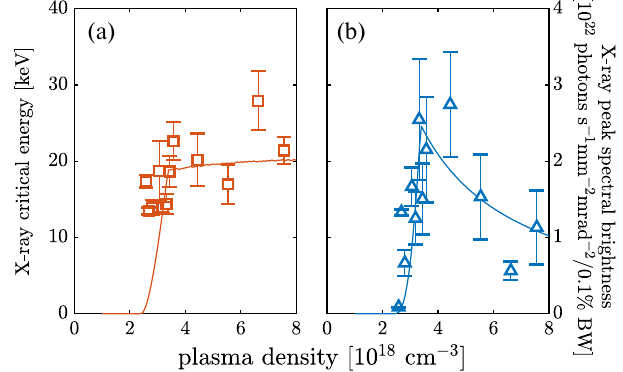
and (b) B 0 as a function of n for c e